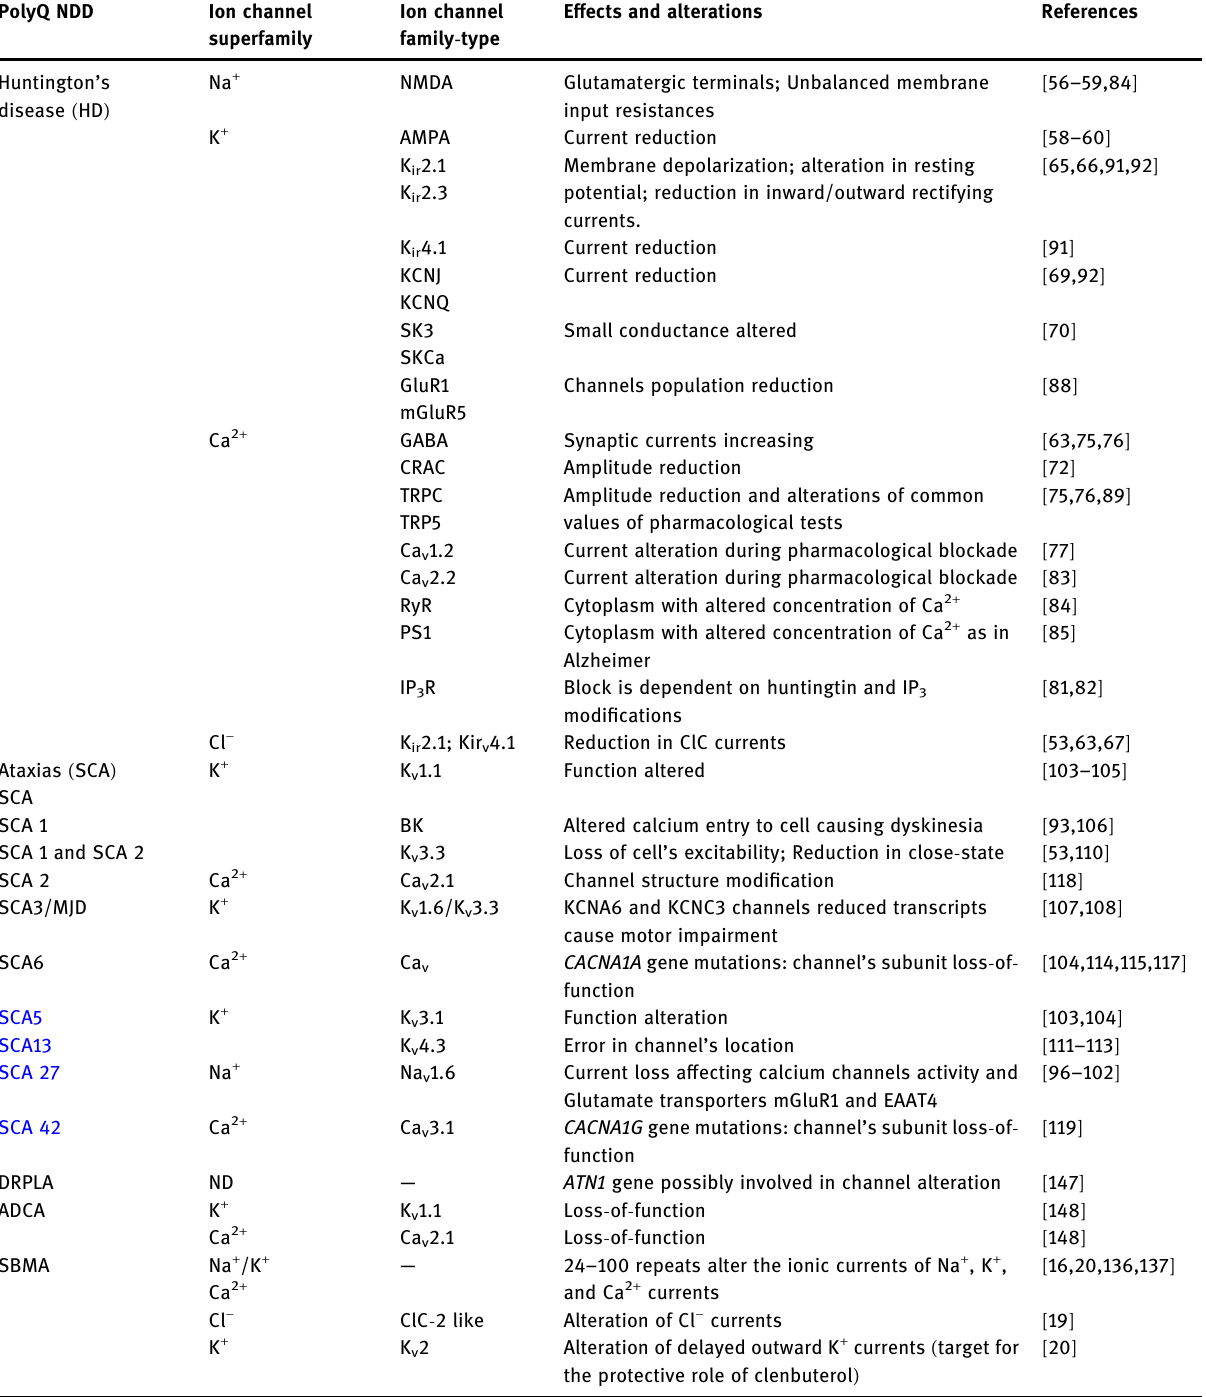
Table 1: Schematic summary of ion channels involved in polyQ NDDs pathophysiology. Some examples of non polyQ SCAs are included for comparison ( acronyms in blue ) . Abbreviations in the